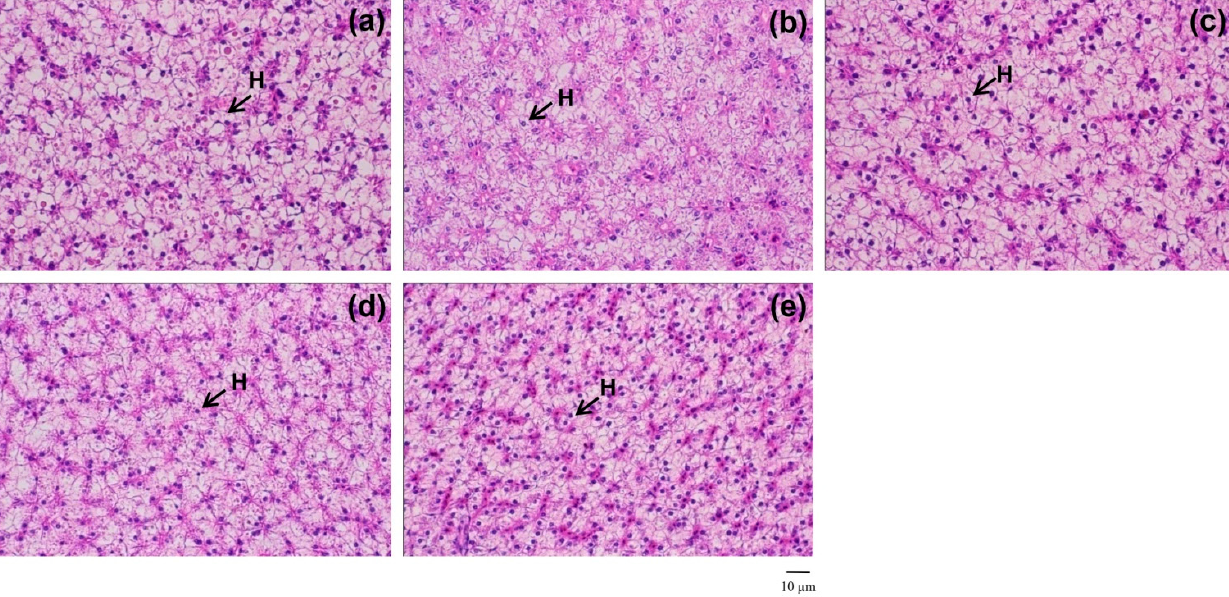
Figure 1. The microanatomy in longitudinal section of liver for sex-reversed red tilapia fed with 0FPKM ( a ), 25FPKM ( b ), 50FPKM ( c ), 75FPKM ( d ) and 100FPKM ( e ) for 12 weeks. Images were taken at 400× magnification and the tissues were stained by hematoxylin and eosin (H&E). H indicates hepatocyte.